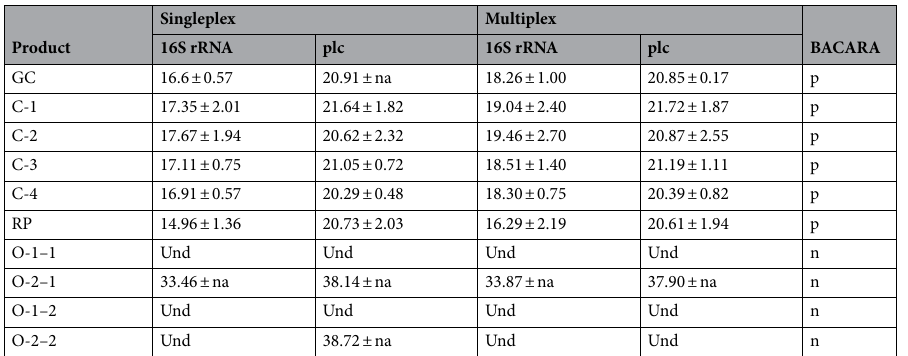
Table 6. C T values for 16 rRNA and PLC of powder-type products using singleplex and multiplex qPCR and detection on BACARA plates*. *Results are shown as C T ± Standard deviation in duplicate for each individual run, 16 S Rdna, PLC phosphatidylcholine-specific phospholipase C, GC green clay, C1‑4 Pink clay, RP Rice powder, O1‑2 Tattoo powder. P growth on BACARA plate agar, n no growth on BACARA plate